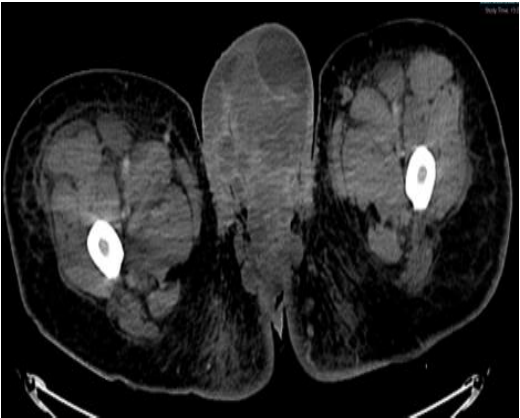
Figure 5. MRI in the axial view T1 TSE FS pre-showing 22 × 30 mm bilateral inguinal lymph node.